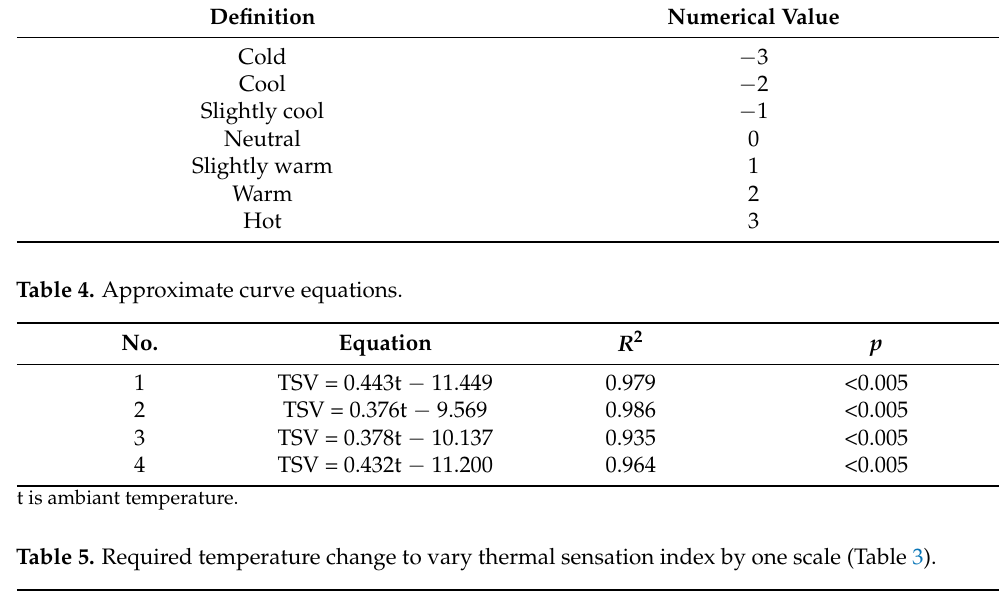
Table 5. Required temperature change to vary thermal sensation index by one scale (Table 3).